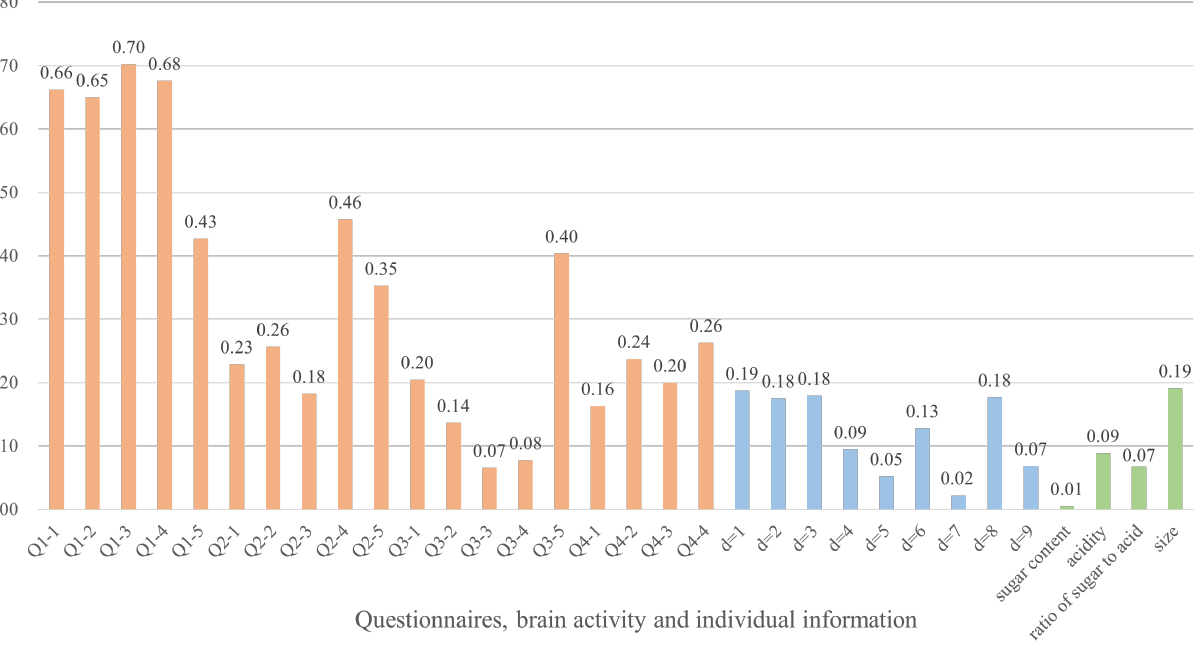
Figure 5. Correlation between taste and other data. The orange, blue, and green bar charts correlate with the questionnaires, brain activity, and individual information,